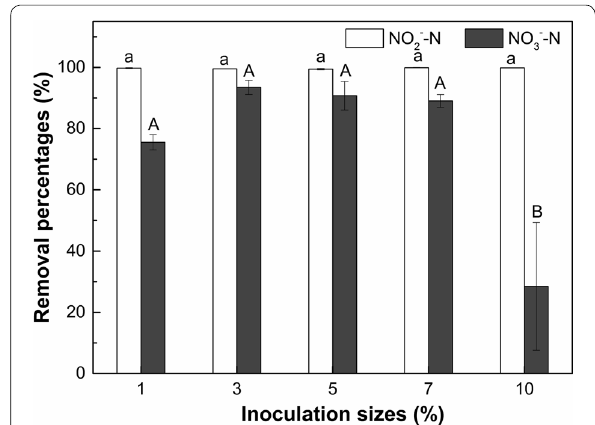
Fig. 6 Effect of initial NaNO 2 concentration on denitrification capacity of strain F1 in saline condition (10 g/L NaCl). Values represent the mean of three replicates and error bars represent standard deviations. Columns containing different letters indicate significant differences among treatments at p < 0.05 by Tukey’s test